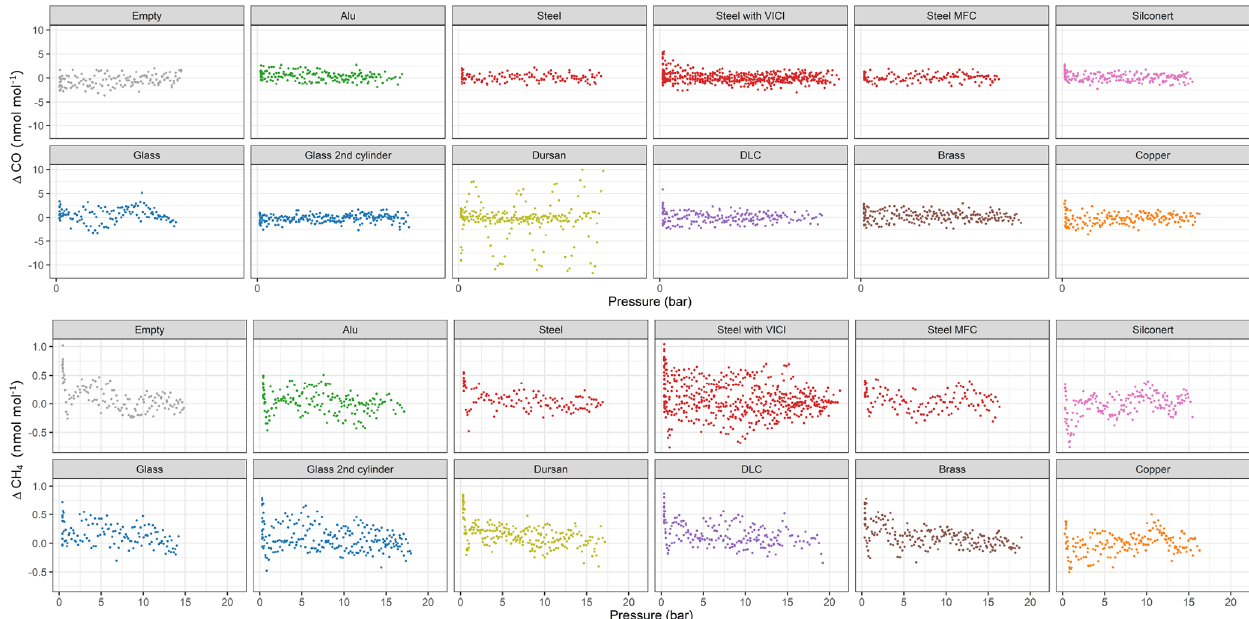
Figure A1. Amount fraction differences compared to the start of the experiment for CO and CH 4 for all tested